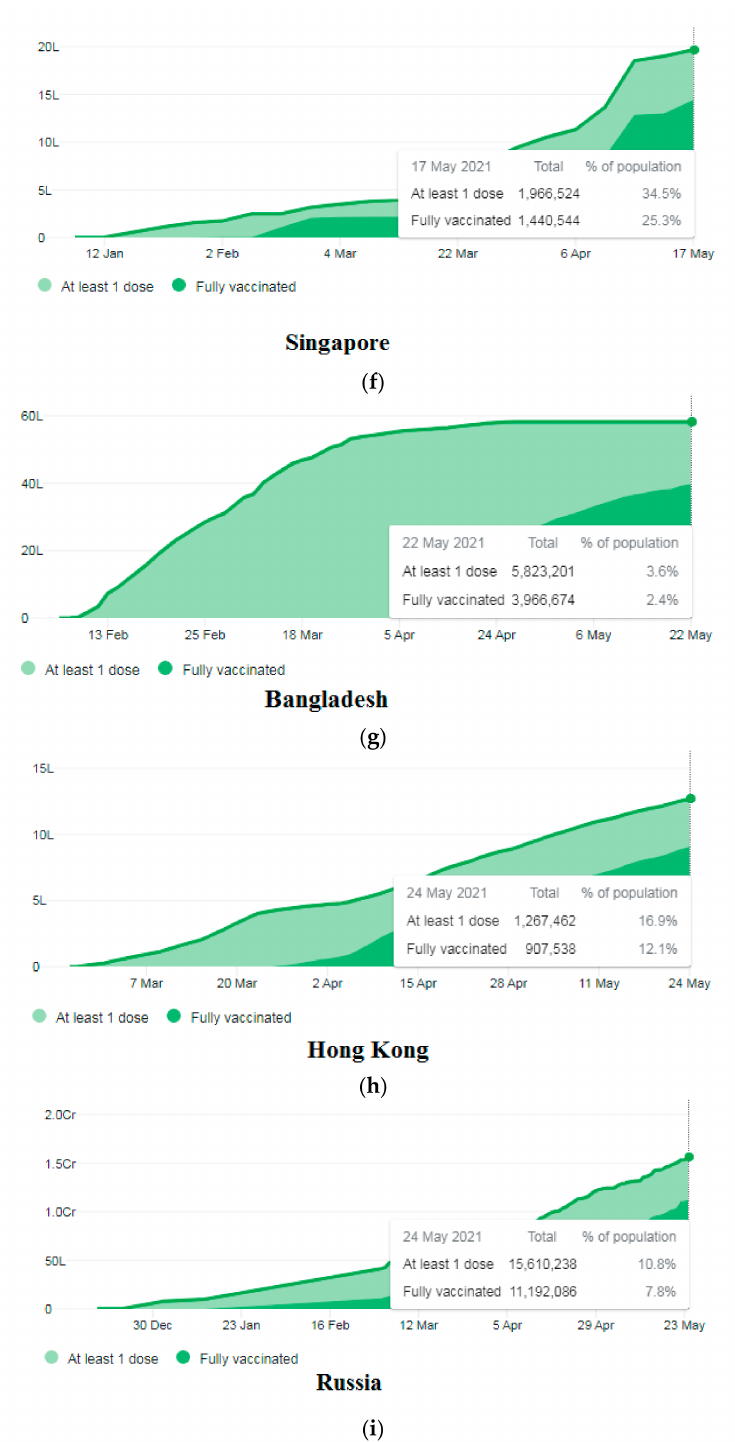
Figure 6. The COVID-19 vaccination status in some Asian countries as of 24 May 2021. ( a ) COVID-19 vaccination status in India. ( b ) COVID-19 vaccination status in China. ( c ) COVID-19 vaccination status in Japan. ( d ) COVID-19 vaccination status in Malaysia. ( e ) COVID-19 vaccination status in South Korea. ( f ) COVID-19 vaccination status in Singapore. ( g ) COVID-19 vaccination status in Bangladesh. ( h ) COVID-19 vaccination status in Hong Kong. ( i ) COVID-19 vaccination status in Russia. (Data source: Our World in